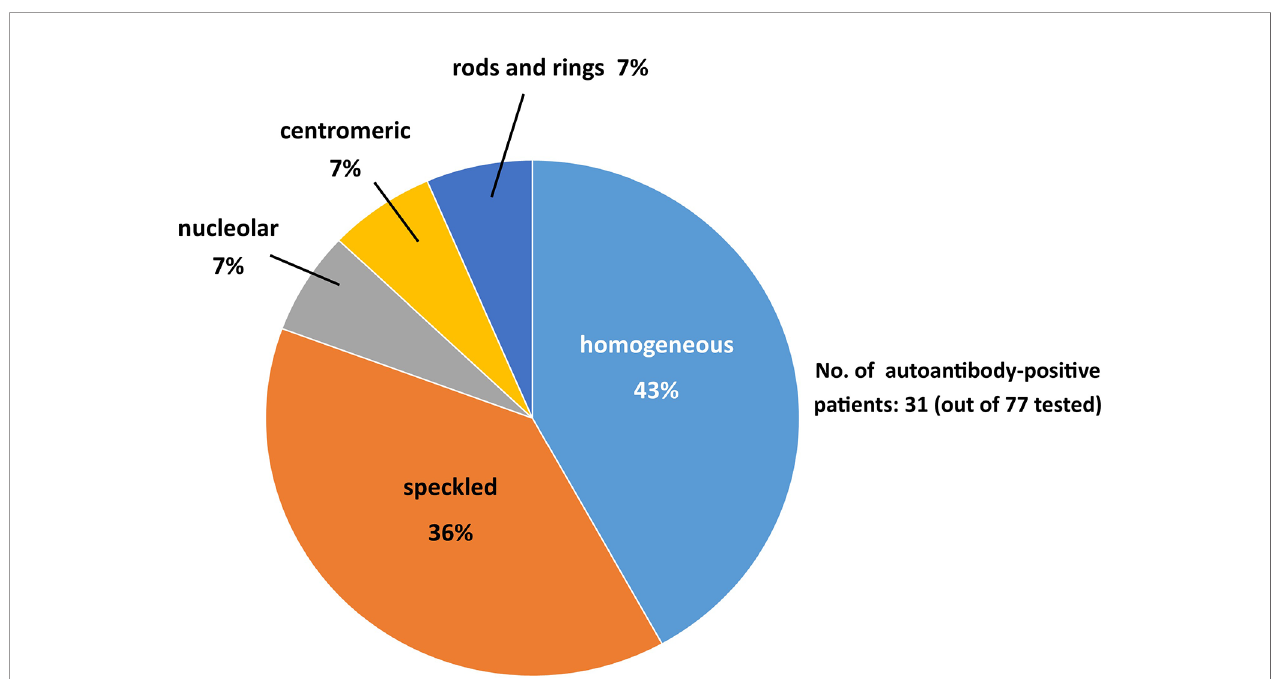
FIGURE 2 | Prevalence of ANA patterns in HCV-infected patients.